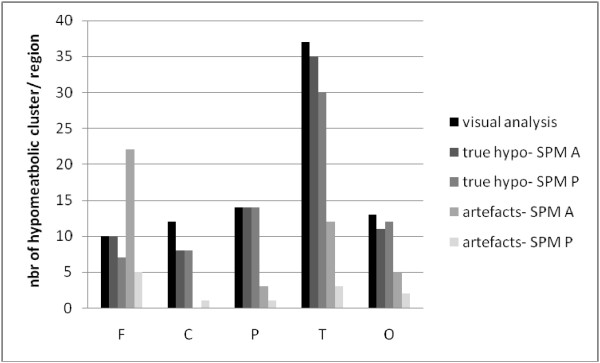
Cortical location of the hypometabolic areas.X axis presents the number of hypometabolic areas using visual analysis (n = 86) and of hypometabolic clusters (true hypometabolic areas and artifacts) using SPM-P (n = 83) and SPM-A (n = 120), according to their regional location on the cortex: F, frontal; C, central or opercular; P, parietal; T, temporal or insular; O, occipital. Y axis presents the number of hypometabolic areas among the 470 regions visually analyzed (47 patients, ten regions/patient). Notice that visual analysis is equal or superior to SPM to identify a hypometabolic area in any region, and both SPM procedures are quite equivalent to identify a true hypometabolic cluster in any region, but SPM-A identifies more artifacts than SPM-P, particularly in the frontal and temporal cortices, the most frequent hypometabolic locations.